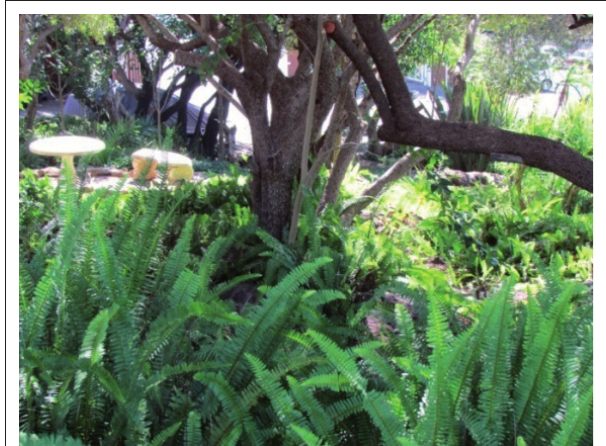
FIGUUR 8: Tuine waar die kinders kan